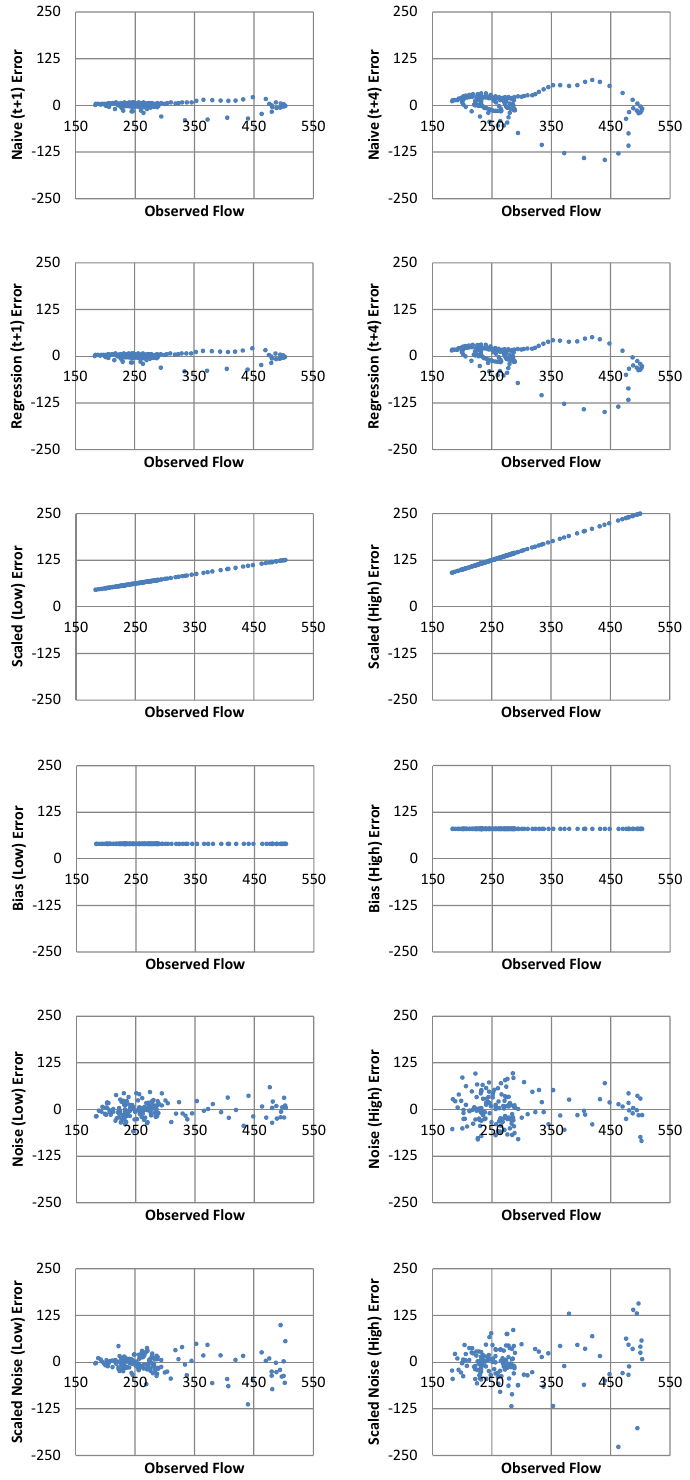
Fig. 2. Error plots for experimental data series (measurements in m 3 s − 1 × 10 2 Fig. 2: Error plots for experimental data series (measurements in m 3 s -1 x 10 2 ) Fig. 2: Error plots for experimental data series (measurements in m 3 s -1 x 10 2 ) Fig. 2: Error plots for experimental data series (measurements in m 3 s -1 x 10 2 )